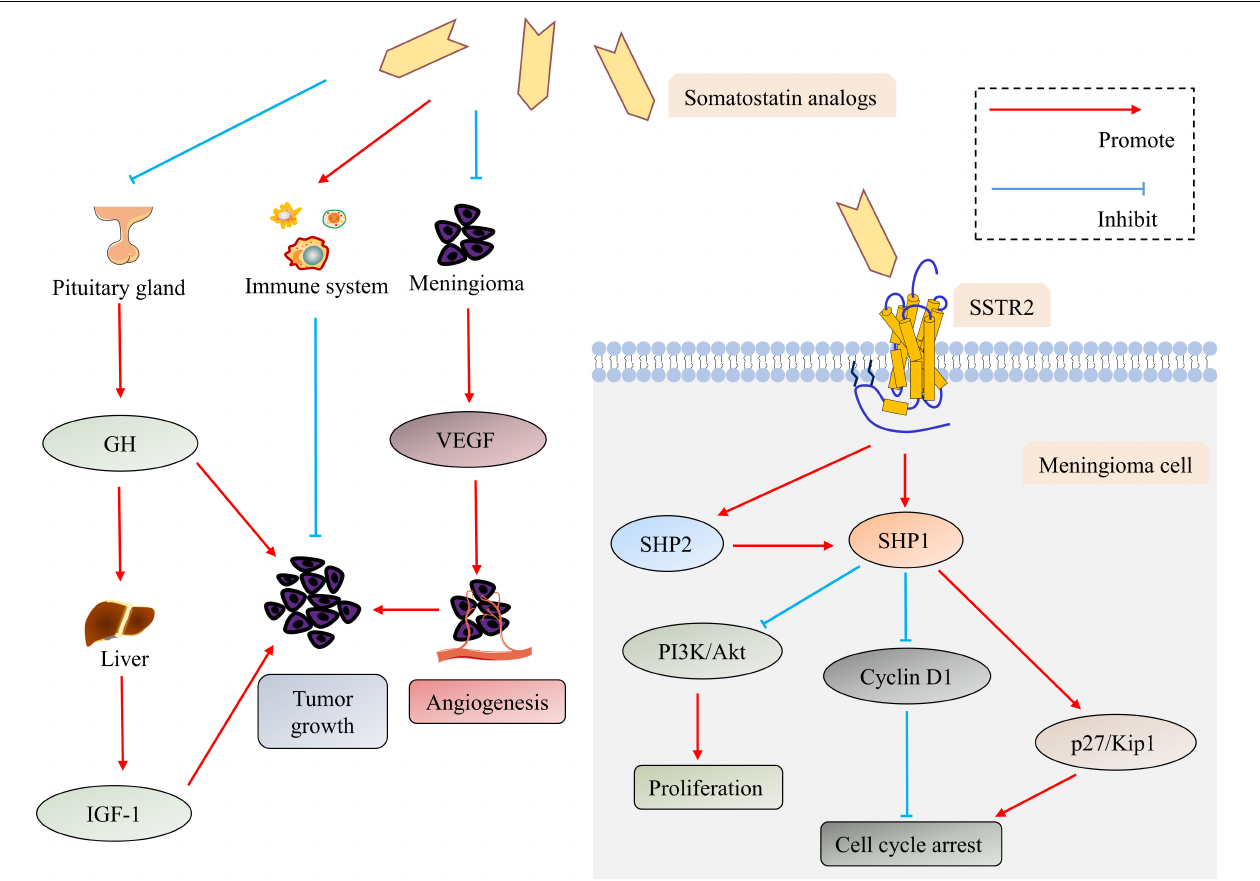
FIGURE 2 | The direct and indirect antitumor mechanisms of the somatostatin analogs in meningioma. Somatostatin analogs exert their direct antitumor effects by binding to SSTR2, which leads to the activation of SHP1 and SHP2. SHP2 can further activate SHP1. SHP1 mediates antiproliferative action through inhibiting the PI3K/Akt pathway and induces cell cycle arrest through down-regulating cyclin D1 while up-regulating p27/Kip 1. Suppressing secretion of VEGF and GH/IGF-1 and activating the immune system are involved in indirect antitumor mechanisms of somatostatin analogs. Abbreviations: Akt, protein kinase B; GH, growth hormone; insulin-like growth factor-1 (IGF-1); PI3K, phosphatidylinositol 3-kinase; SHP1, SH2-containing phosphatase-1; SHP2, SH2-containing phosphatase-2; SSTR, somatostatin receptor; and VEGF, vascular endothelial growth factor.